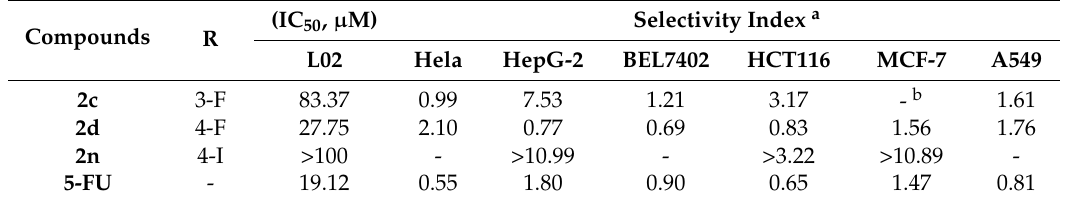
Table 3. In vitro antiproliferative activities of compounds 2c , 2d , and 2n against normal cell line